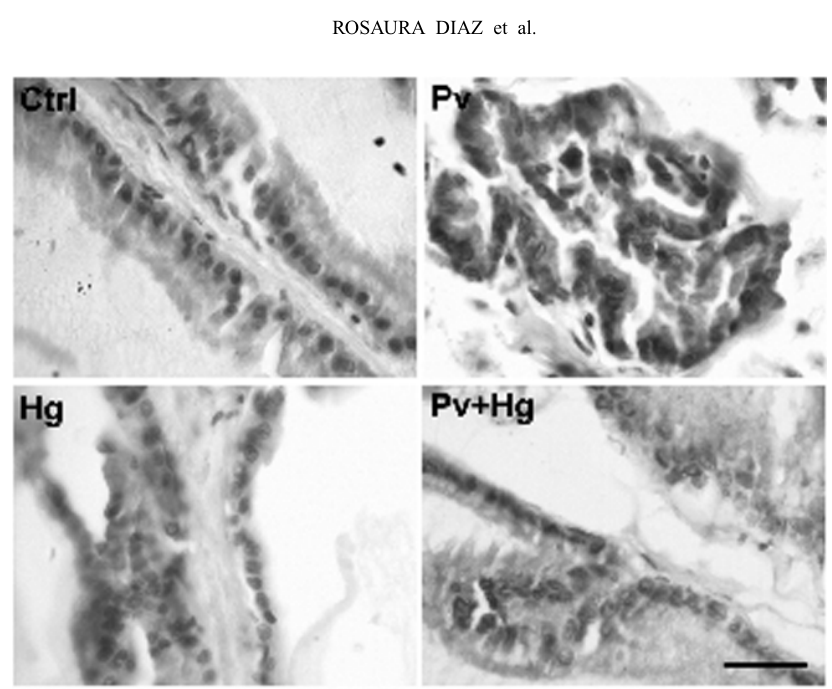
Fig. 4 – Prostate histology. Histological changes obtained after denervation of pelvic (Pv) and hypogastric (Hg) nerves alone or in combination (Pv+Hg). Notice the devastating effect on the epithelium after these autonomic denervations. Bar = 200 μ